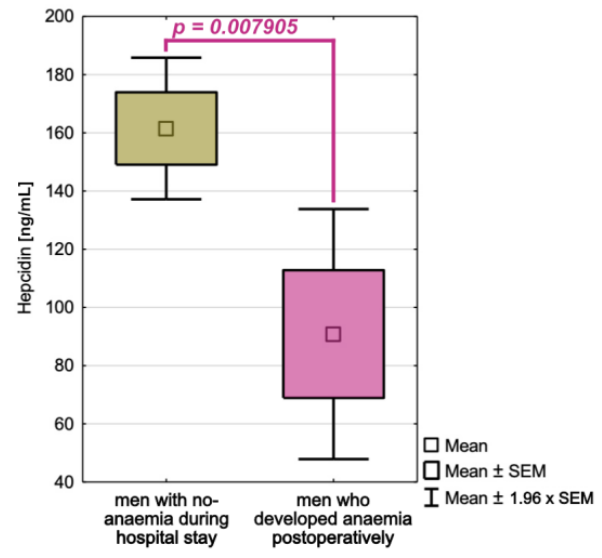
Figure 6. Hepcidin concentration differences between men without anaemia and men who developed anaemia during hospitalization and had two complete blood count examinations.